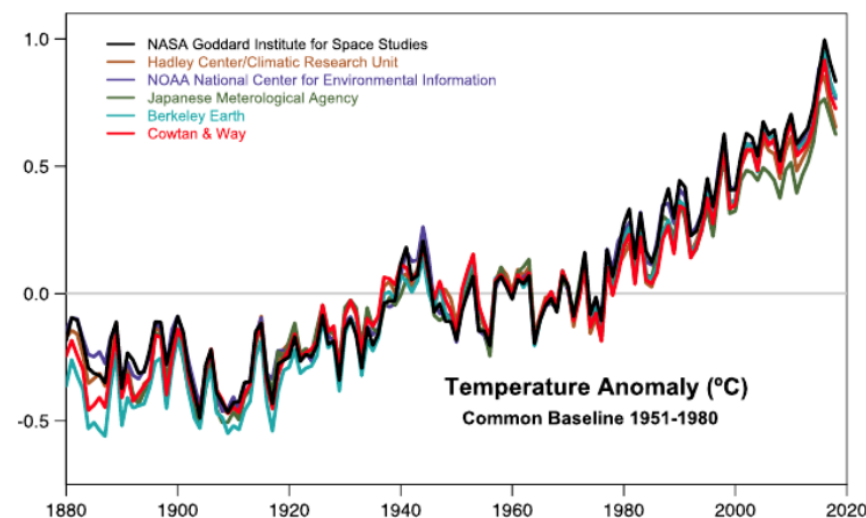
Figure 2. Comparison of six analyses of the annually and globally averaged surface temperature anomalies through 2018. The abscissa is time in years, and the ordinate is temperature anomalies in ◦ C with respect to a 30-year climatological average for 1951–1980. NASA stands for the National Aeronautics and Space Administration; NOAA stands for the National Oceanic and Atmospheric Administration. Reprinted by permission from John Wiley & Sons Inc.: American Geophysical Union. Journal of Geophysical Research: Atmospheres. Improvements in the GISTEMP Uncertainty Model. Lenssen et al. (2019), © 2019. American Geophysical Union. All Rights Reserved. 2019.